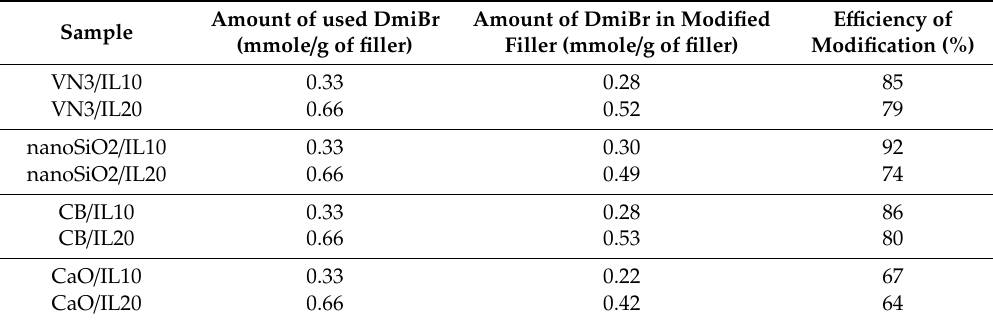
Table 3. DmiBr content in modified fillers and efficiencies of modification.